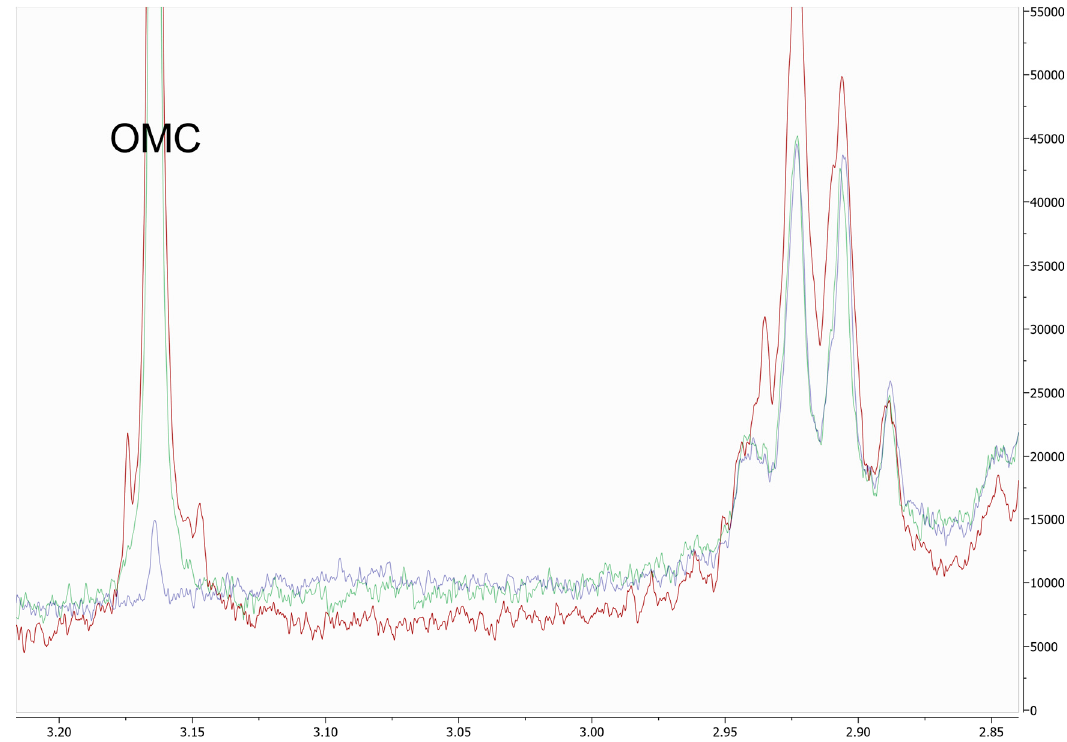
Figure 2. NMR range besides the OMC signal showing matrix interferences from resonances of fatty acid signals around 2.9 ppm. Over-quantification can be avoided by subtracting the noise range (3.04 ppm–3.10 ppm).